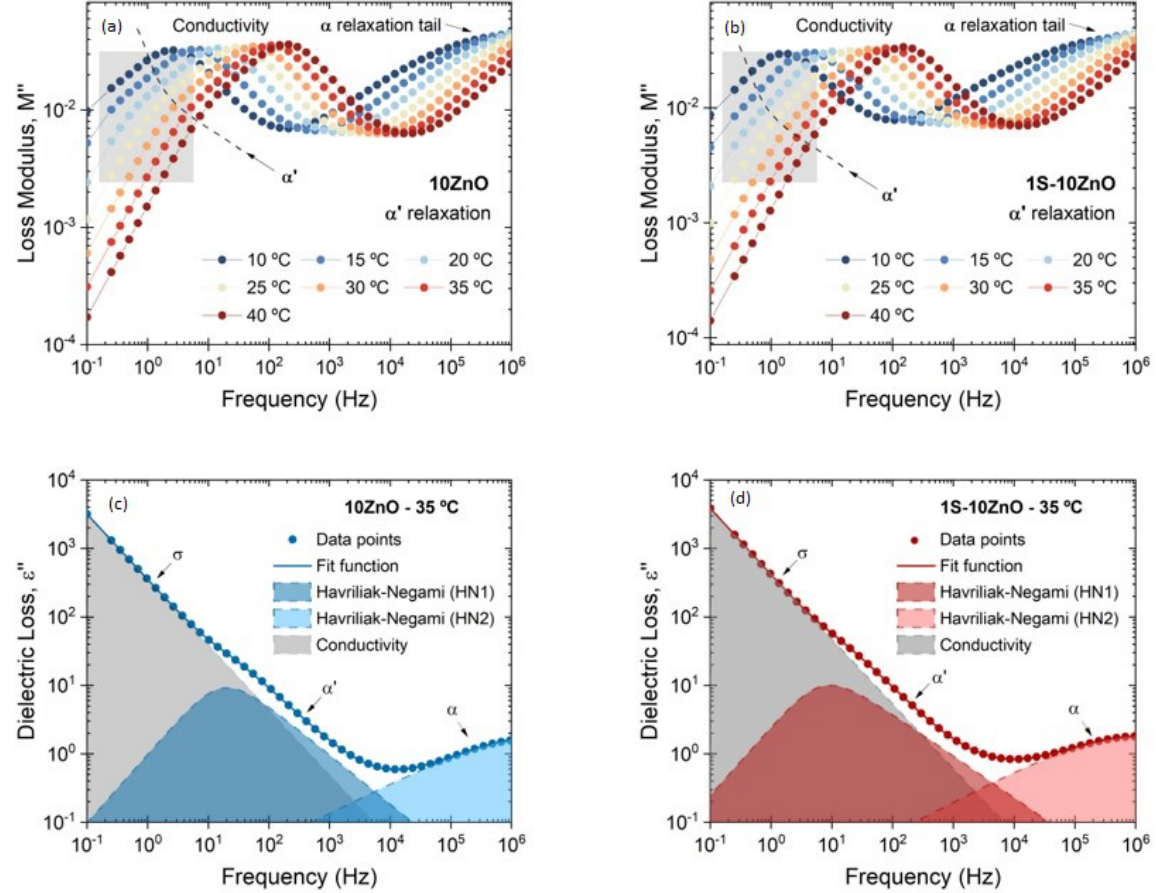
Figure 9. α (cid:48) relaxation determined by means of modulus ( M (cid:48)(cid:48) ) in ( a ) 10 ZnO and ( b ) 1S-10 ZnO and by means of dielectric loss ( ε (cid:48)(cid:48) ) in ( c ) 10 ZnO and ( d ) 1S-10 ZnO at 35 ◦ C. The dashed lines in ( c , d ) indicate the fittings of Havriliak–Negami and power law function to the experimental data at a selected